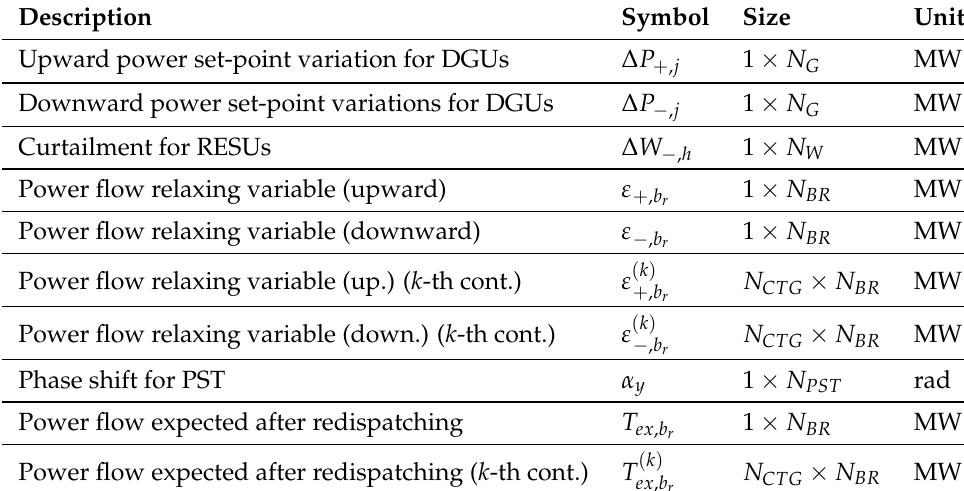
Table 2. Variables for the optimal active power control